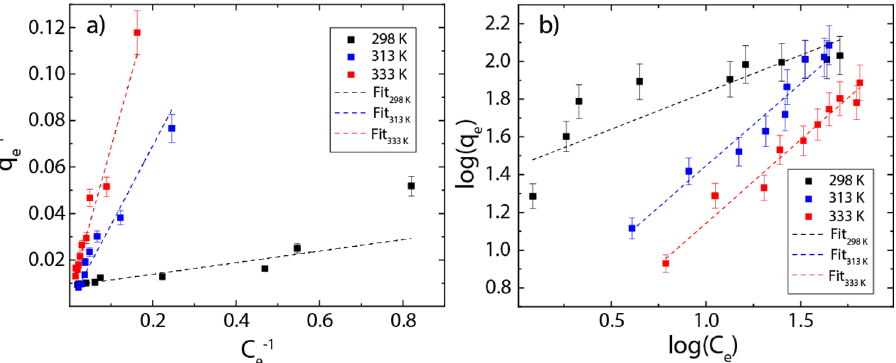
Figure 3. Hg(II) adsorption isotherms for rGO. ( a ) Langmuir linear model ( b ) Freundlich linear